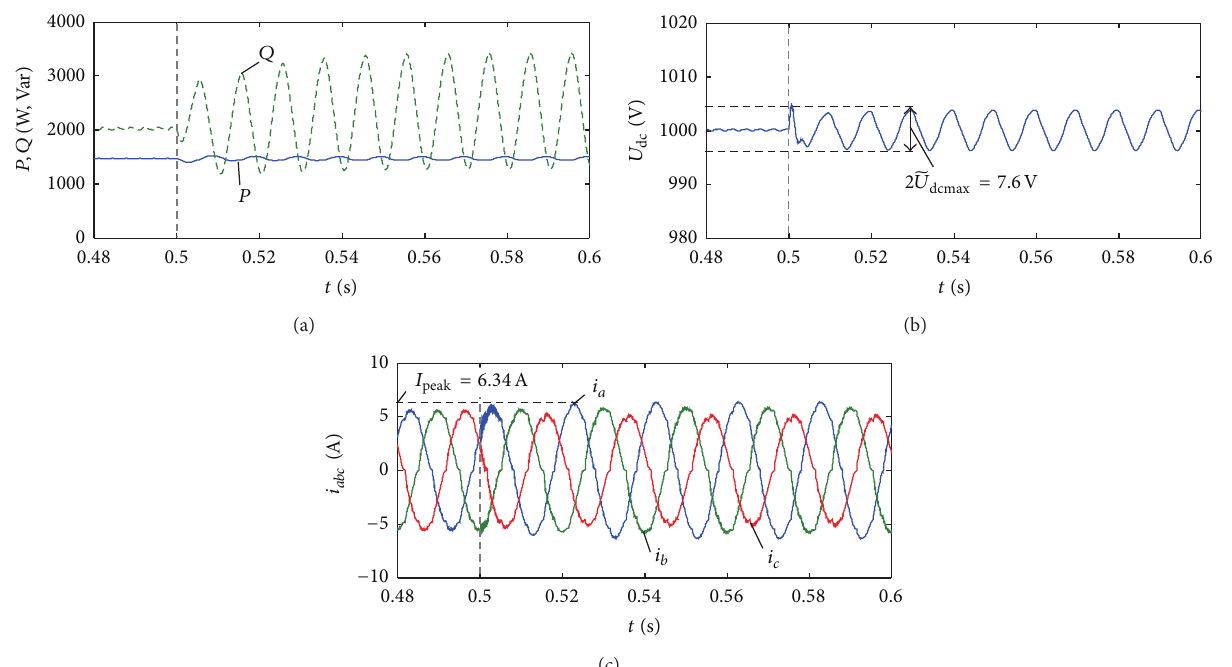
Figure 13: Operating characteristics foroptimal control coefficients. (a)Active and reactive power when 𝑛 = 0.2 . (b)DCvoltage when 𝑛 = 0.2 . (c) Output current when 𝑛 = 0.2